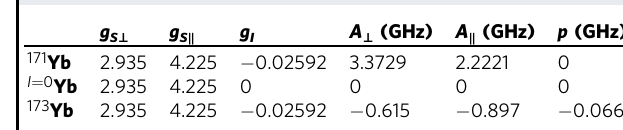
Table 1 Parameters of the effective spin Hamiltonian for different [Yb(trensal)] isotopical